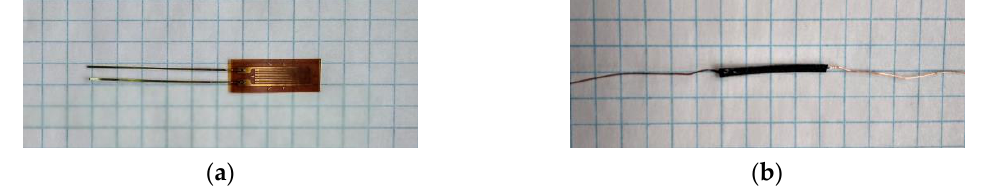
Figure 4. Strain gauge placed on a 5 × 5 mm graduated base, ( a ) metallic on the foil, ( b ) polymer on the paper.